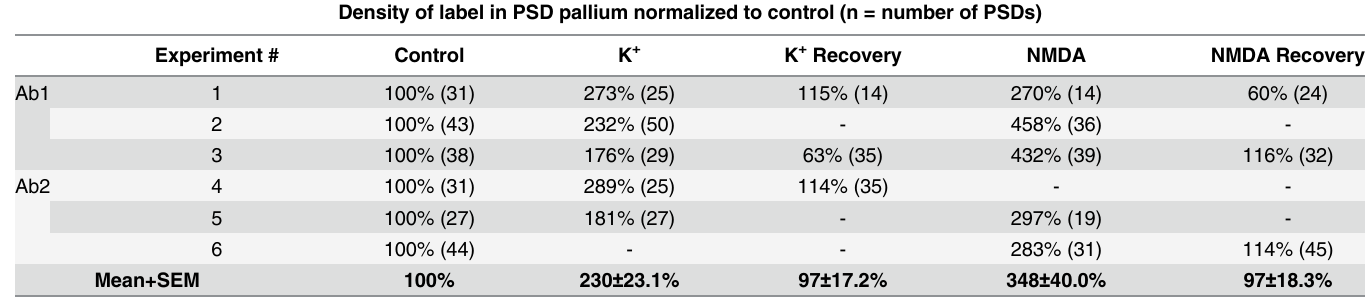
Table 2. AIDA-1 label density at the PSD pallium increases under excitatory conditions and returns to basal levels within 30 min after cessation of the stimulus. Density of label in PSD pallium normalized to control (n = number of